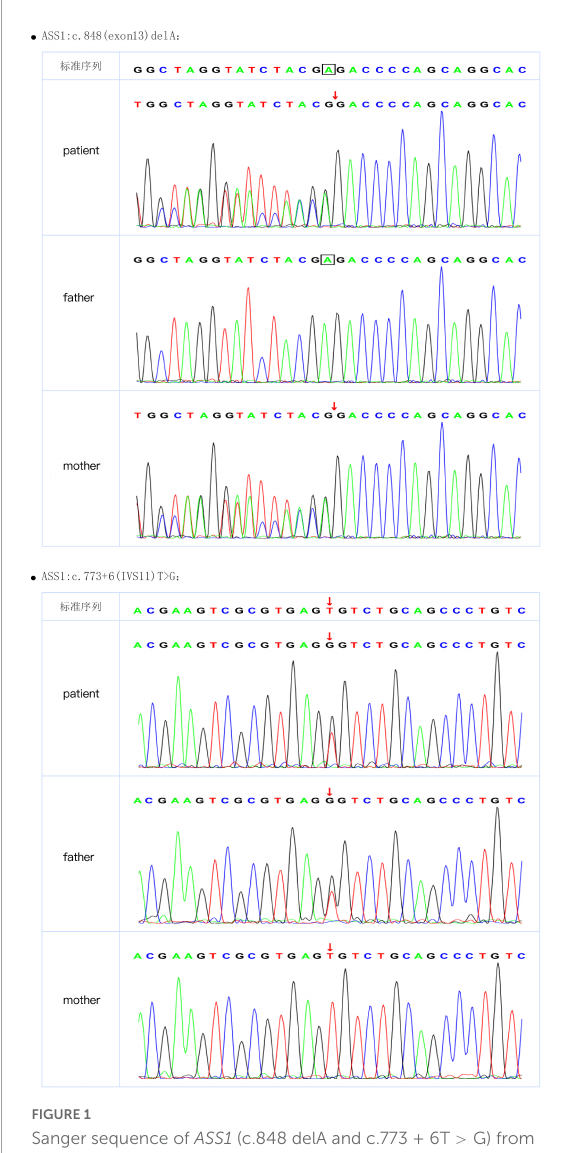
FIGURE1 Sanger sequence of ASS1 (c.848 delA and c.773 + 6T > G) from patient 1 and her